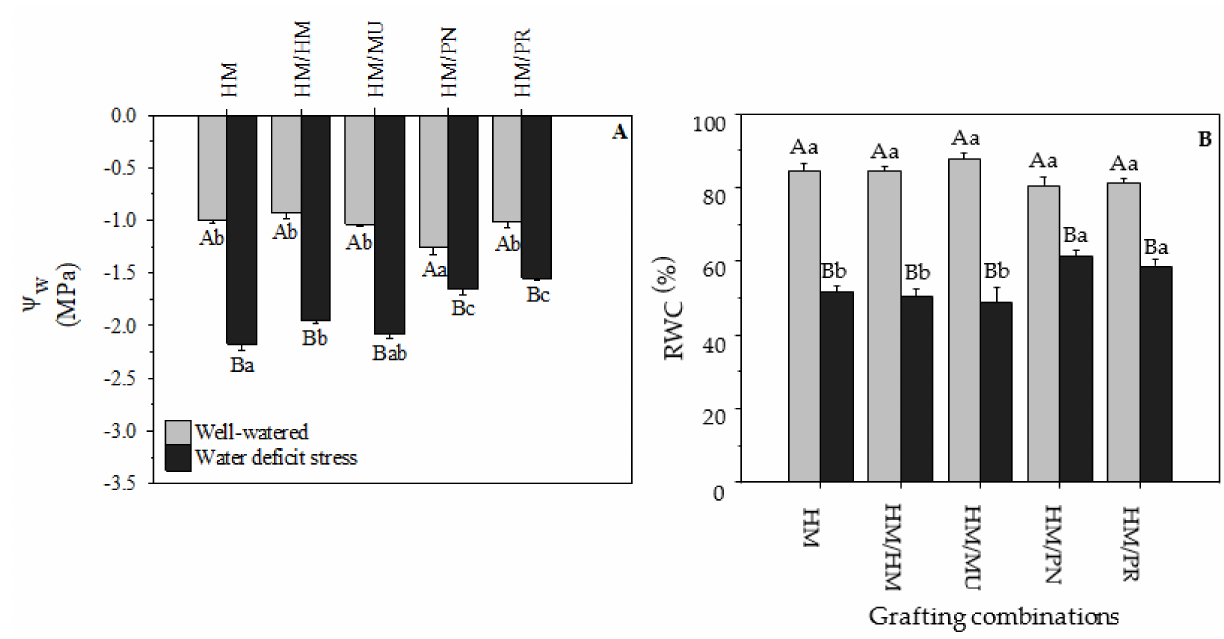
Figure 2. ( A ) Water potential ( Ψ w ) and ( B ) relative water content (RWC) of five grafting combinations under well-watered and water-deficit stress conditions. Capital letters denote significant differences between water regimes within each graft combination and lower-case letters denote significant differences among grafting combinations within each water regime according to the LSD test ( p ≤ 0.05). Columns are mean ± standard error. Note: HM = non-grafted HM 1823; HM/HM = HM 1823 self-grafted; HM/MU = HM 1823 grafted onto Multifort; HM/PN = HM 1823 grafted onto S. pennellii ; and HM/PR = HM 1823 grafted onto S. peruvianum .